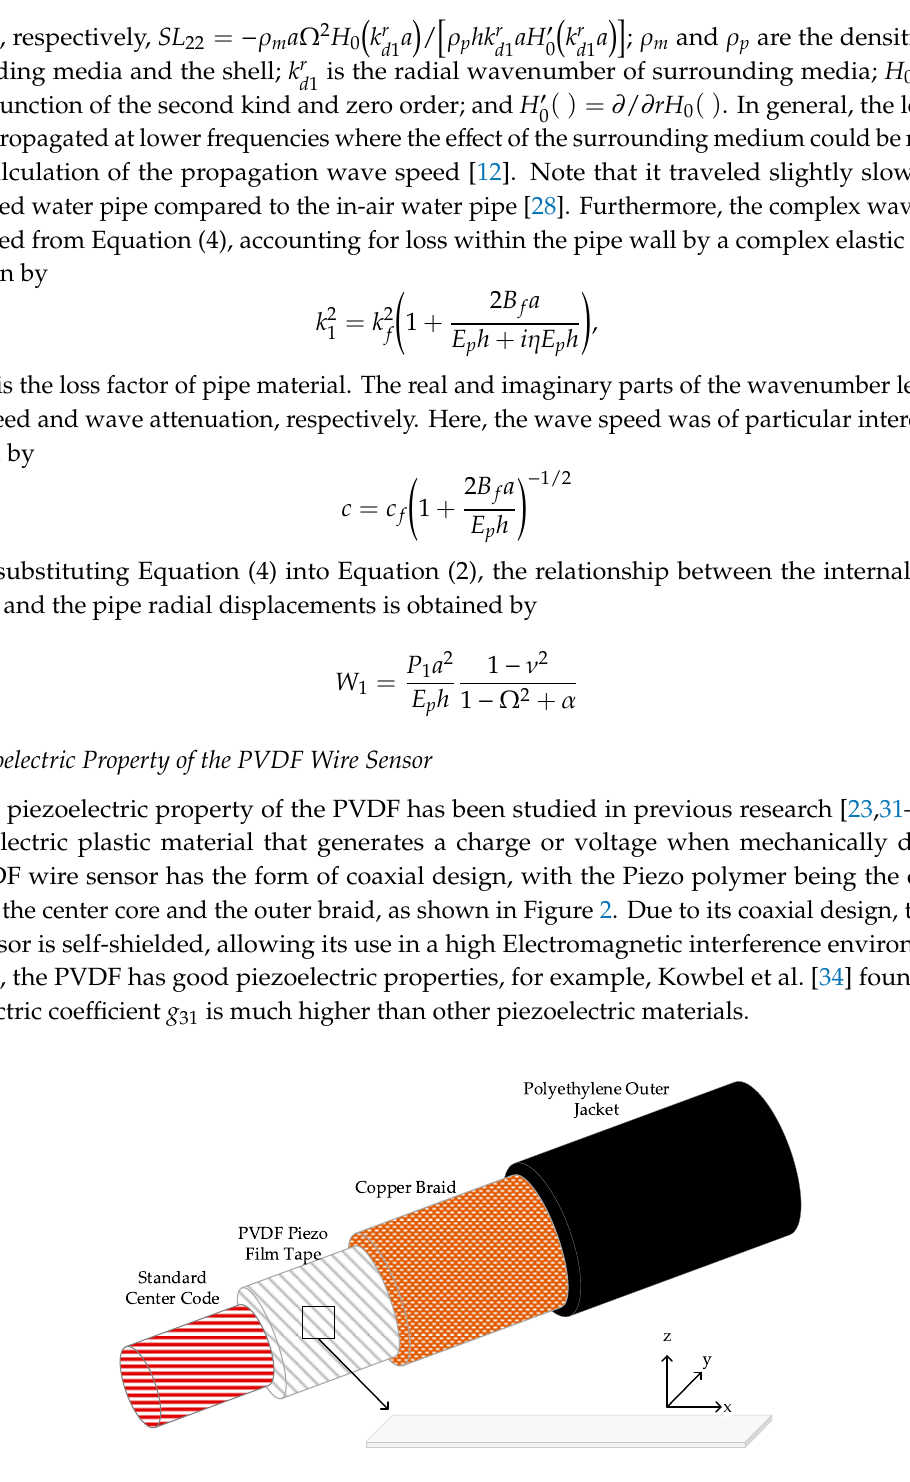
Figure 2. Schematic design of the polyvinylidene fluoride (PVDF) wire sensor.